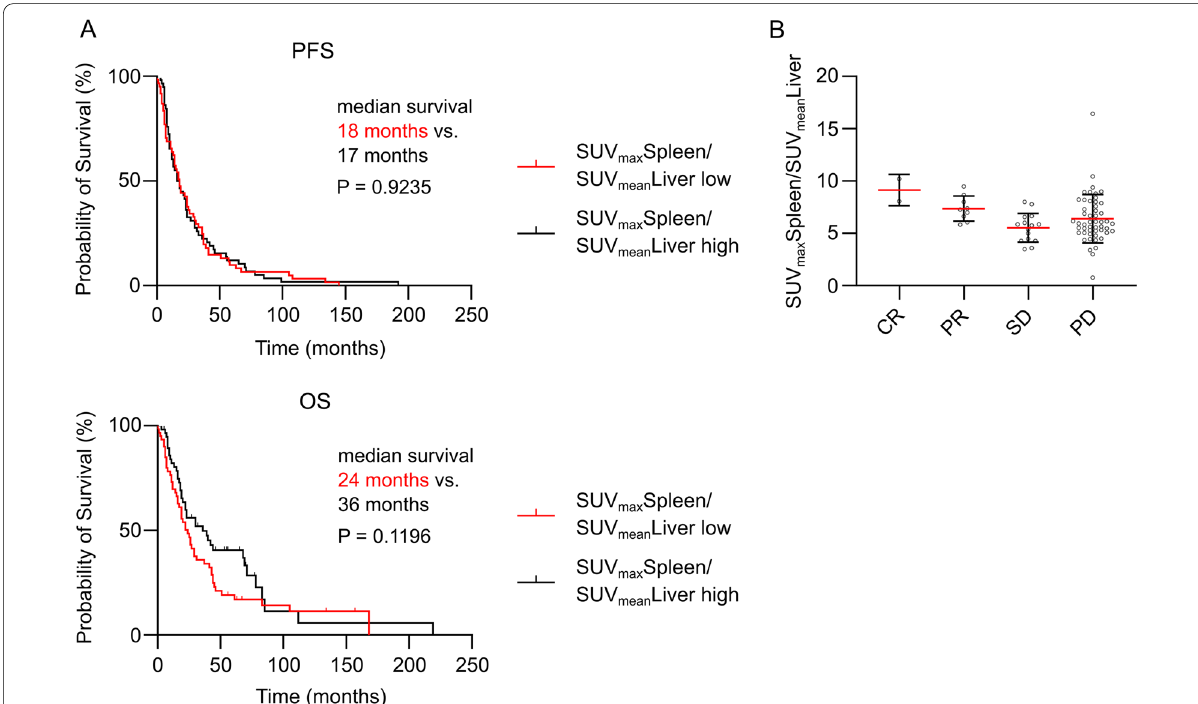
lactate-dehydrogenase (LDH) (U/l), hemoglobin levels (g/dl), peripheral leukocyte count (/nl) and peripheral